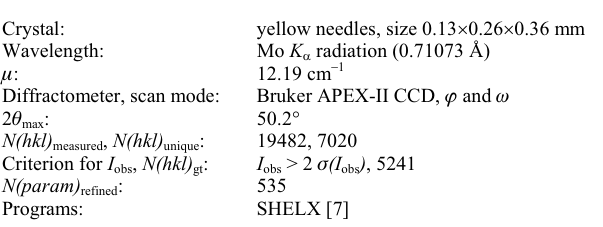
Table 1. Data collection and handling.